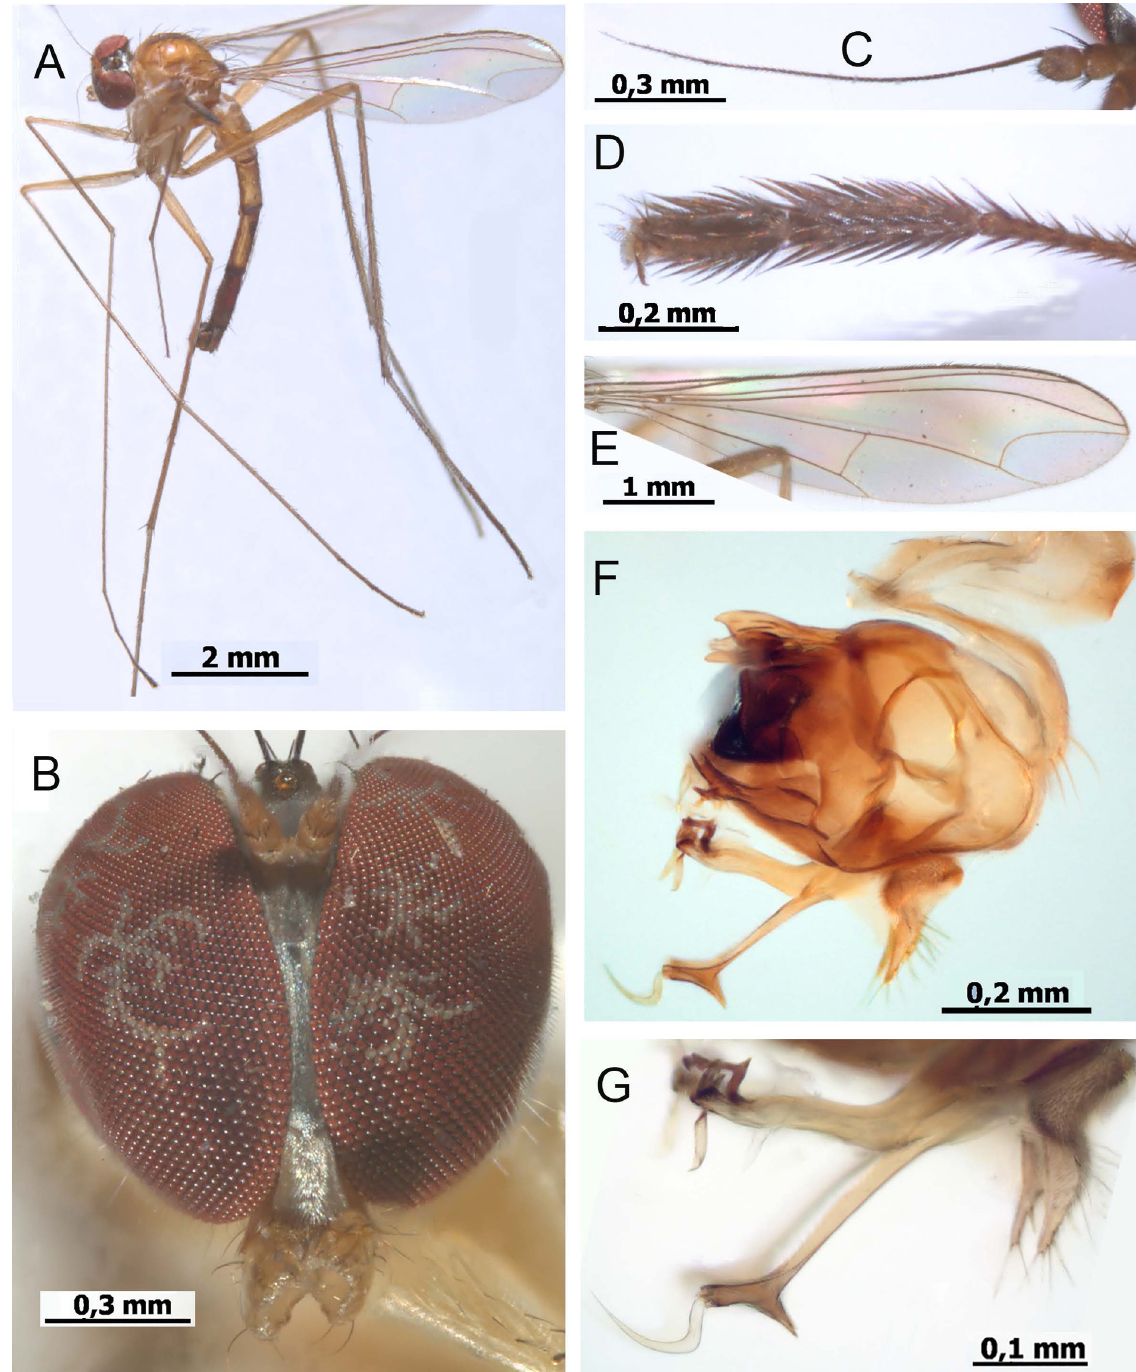
Fig. 11. Amblypsilopus leonidi sp. nov. A–E . Holotype, ♂ (SMNHTAU). F–G . Paratype, ♂ (SMNHTAU). A . Habitus. B . Head. C . Antenna. D . Fore tarsomeres 4–5. E . Wing. F . Hypopygium, left lateral view, reflected light. G . Cercal lobes, lateral view, transmitted